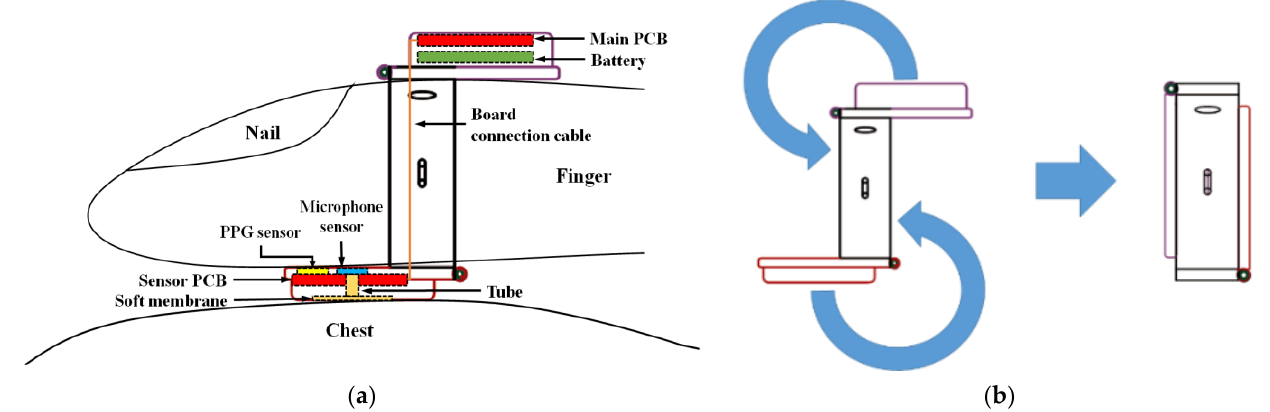
Figure 1. Concept of the proposed finger-ring-shaped smart stethoscope: ( a ) structure and operating principle of the smart stethoscope for PPG signal measurement and heart-sound acquisition; ( b ) collapsing mechanism of the smart stethoscope for compact portability.